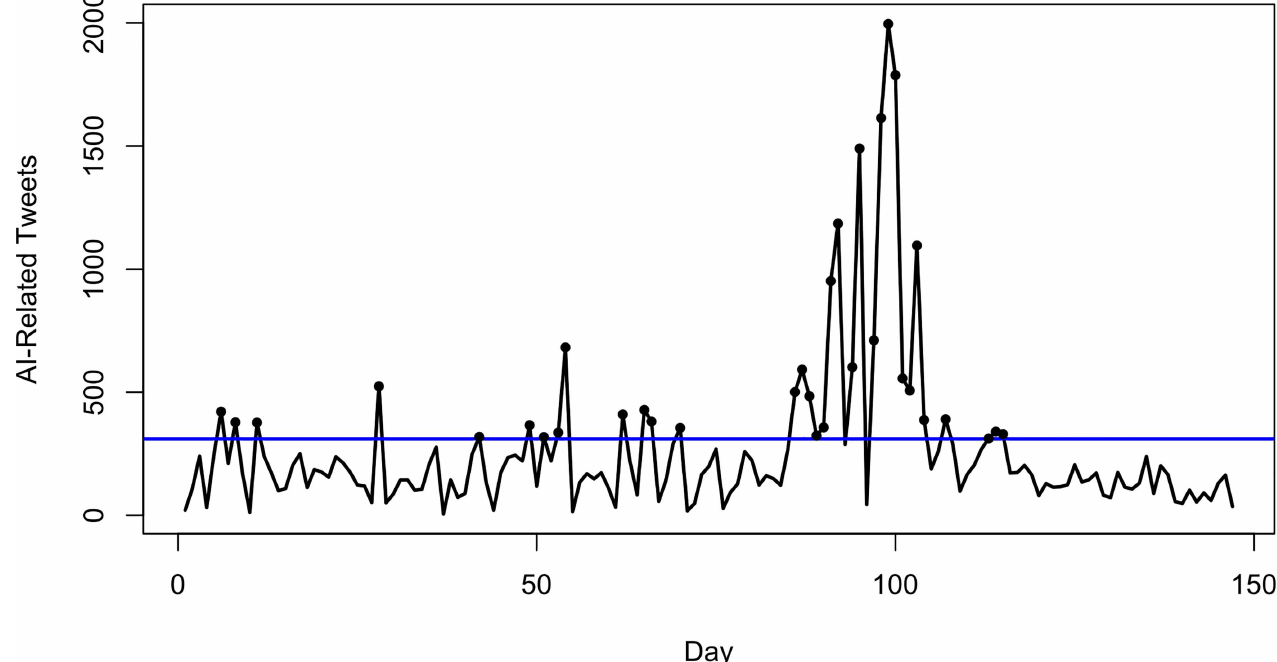
Fig 5. Observed daily time series of AI-related Twitter activity, black circles indicate significant errors (possible outbreaks) based on the static threshold criterion (blue